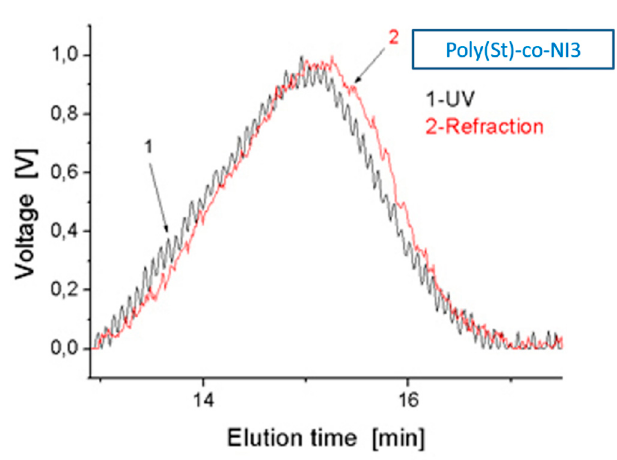
Figure 1. Gel permeation chromatograms with double detection of poly (St-co-NI3) in a tetrahydrofuran solution.